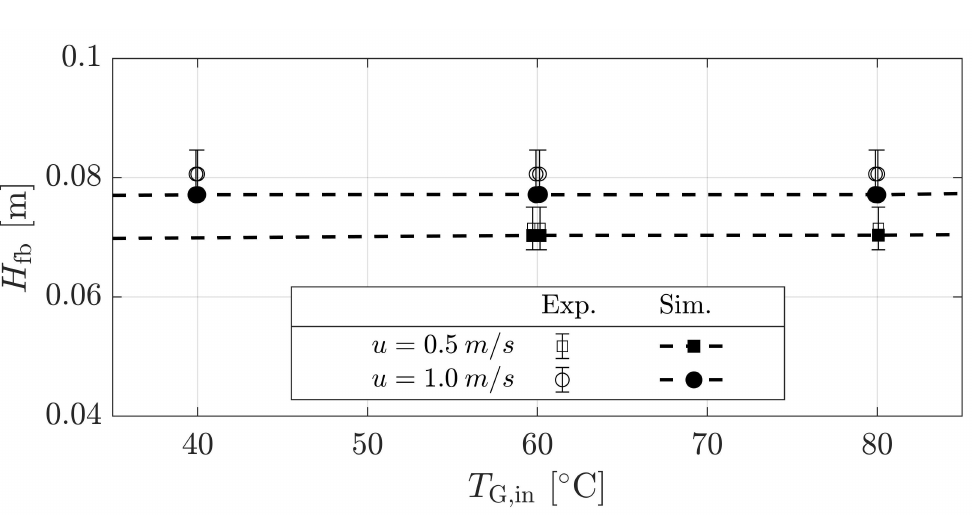
Figure 8. Comparison of bed height ( H fb ), measured in the GF3 lab-scale dryer and model predictions for Cellets with an outflow hole height of